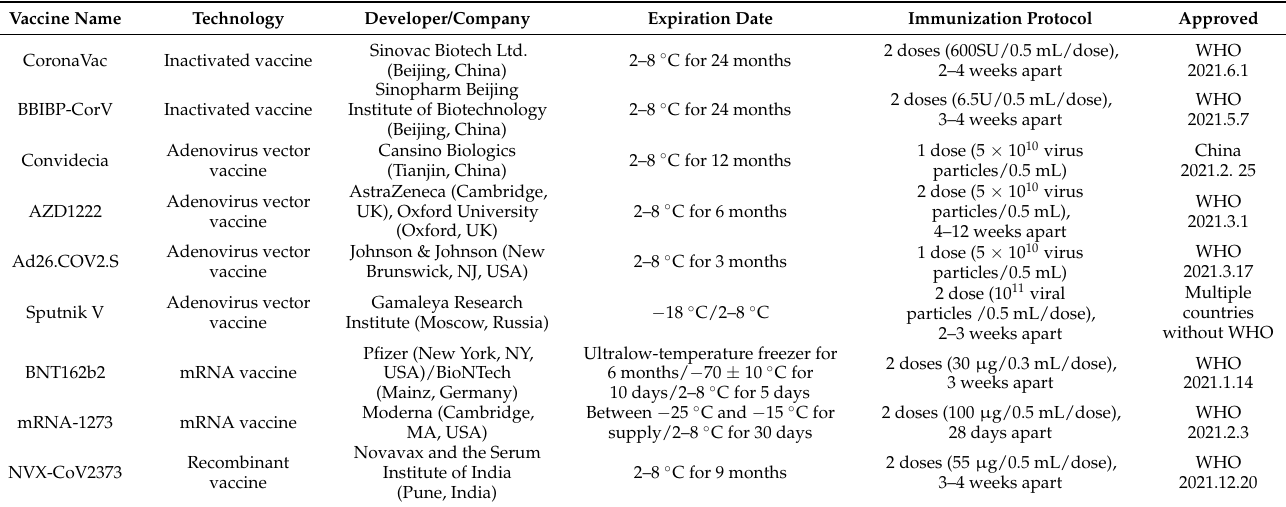
Table 1. Several granted COVID-19 vaccines and